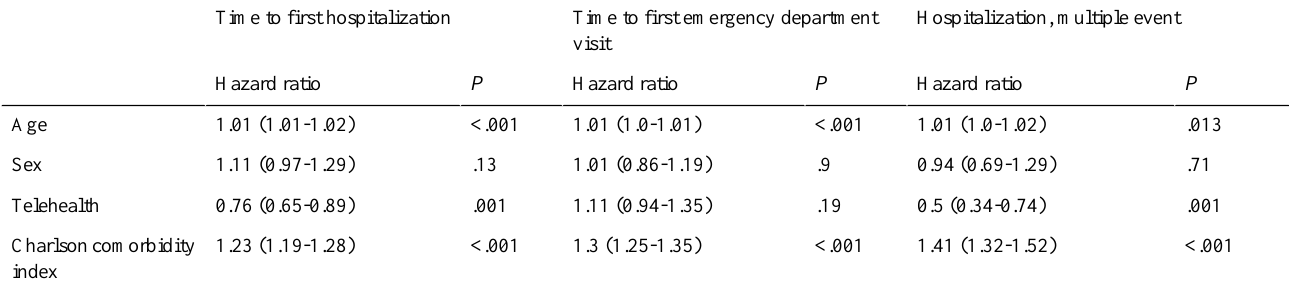
Table 3. Multivariate Cox regression analysis for event-free